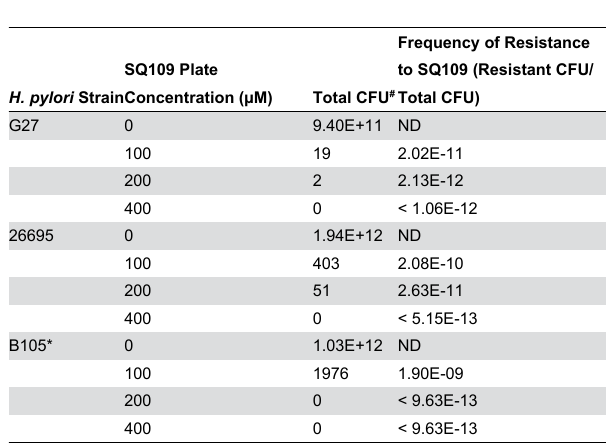
CFU = Colony Forming Units. Low passage clinical isolate from a gastric ulcer patient. The data represent results from at least four independent experiments performed in triplicate